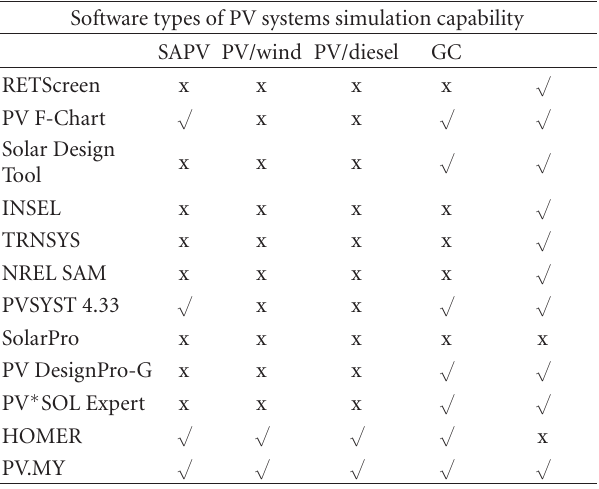
Table 1: Comparison of commercial PV software tools. Software types of PV systems simulation